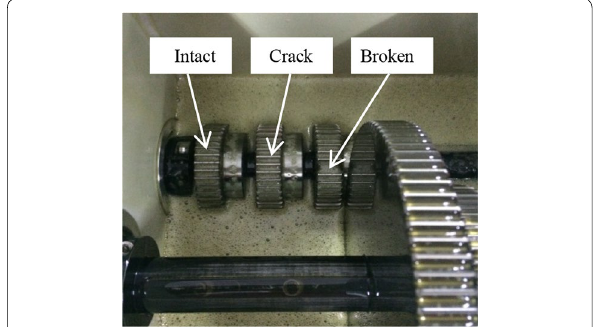
Figure 5 Intact and localized defect